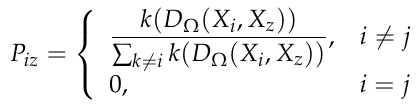
Figure 2. Frequency component of a sample fault in the network.